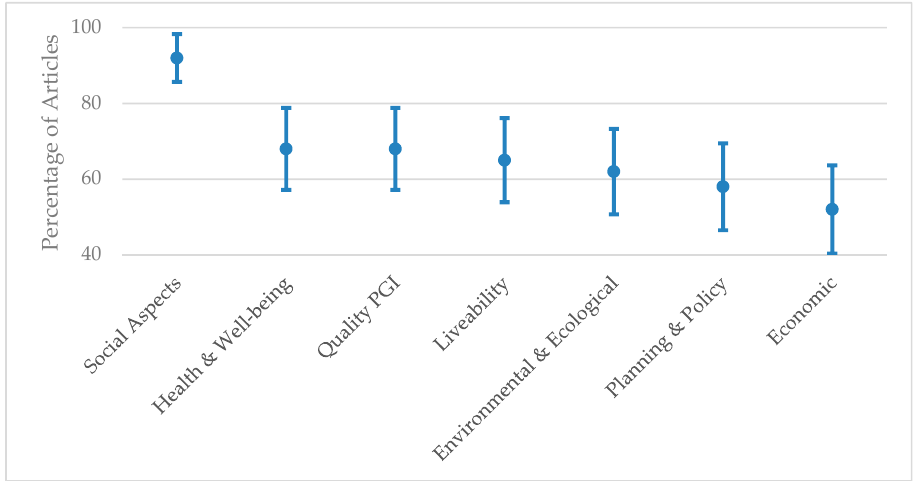
Figure 7. Rate of reporting (± 95% confidence intervals (CIs) of the proportions) of the research focus Figure 6. Rate of reporting ( ± 95% confidence intervals (CIs) of the proportions) of the four research approaches used to investigate the contribution that PGI makes to urban livability identified by this review (n = 71). Percentages add to greater than 100% because the articles that reported a mixed methods approach to research are reported in multiple